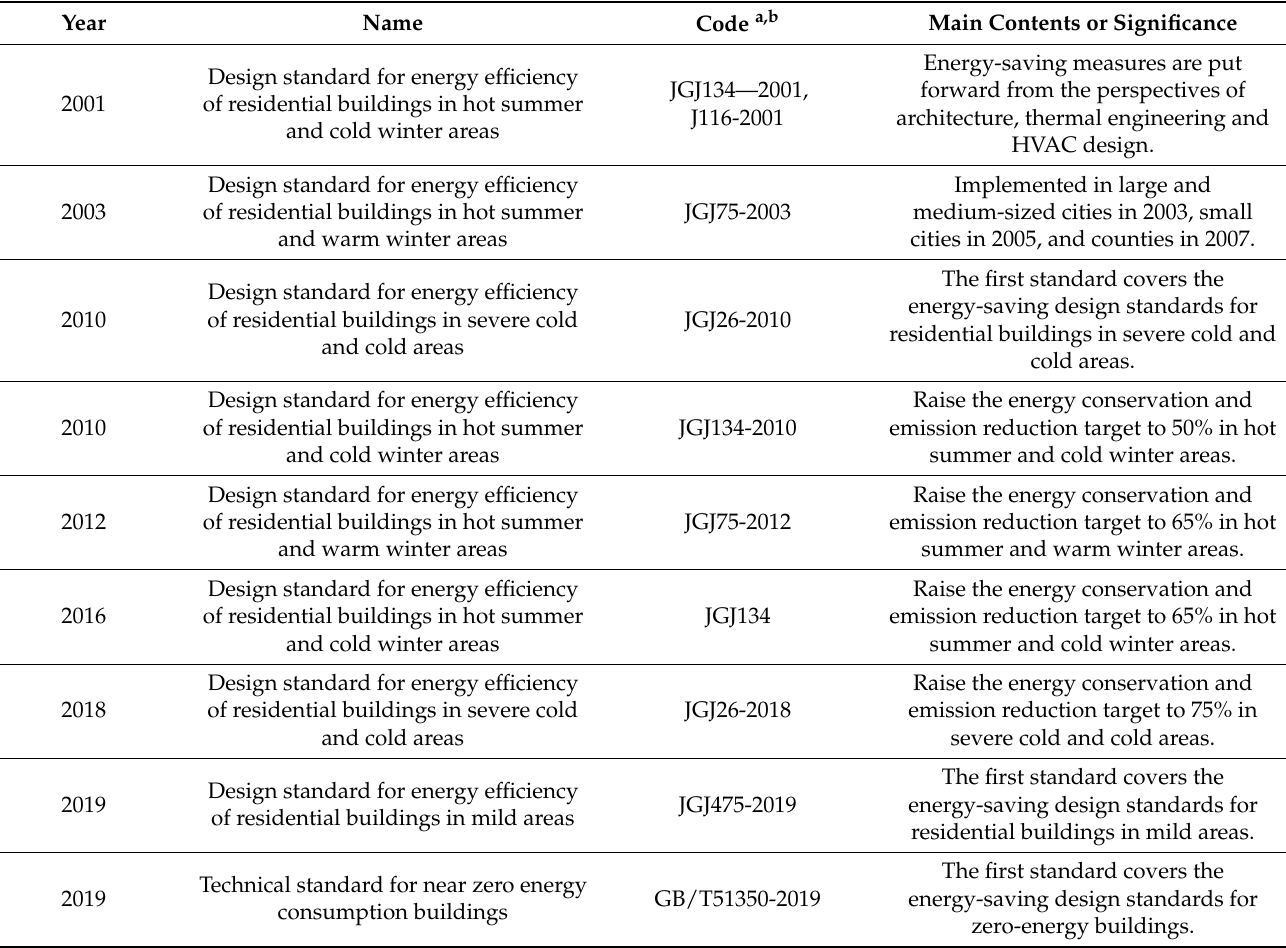
Table A2. A Review of the main energy efficiency codes for China’s residential buildings